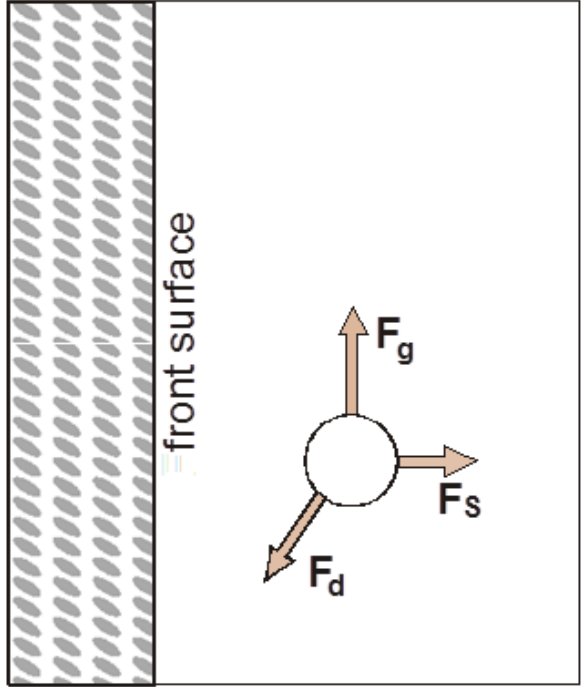
Figure 2. System of forces acting on a particle in the area of influence of the solidification front. Gravitational force (i.e., the difference between buoyancy and gravity)